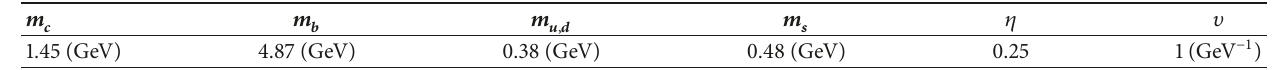
Table 1: Parameters for HLM.